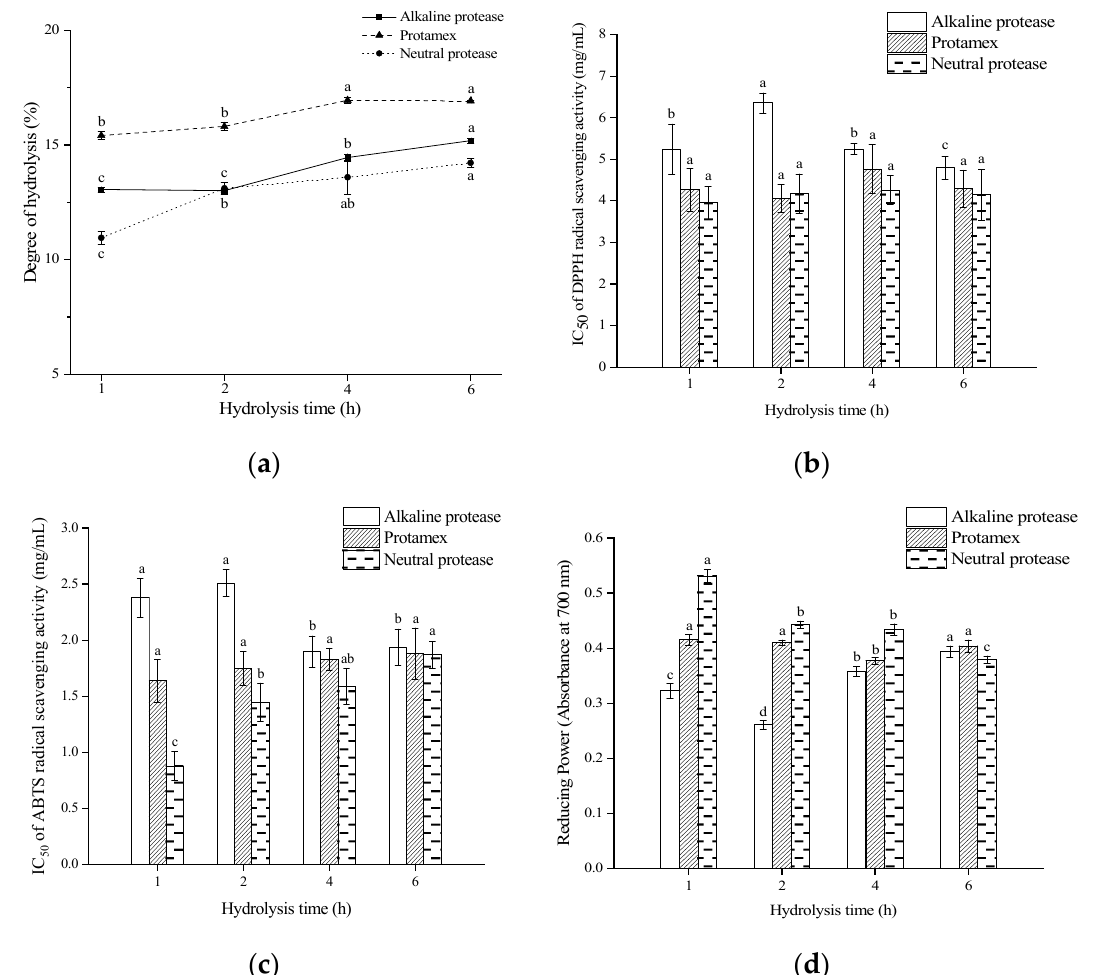
Figure 1. The DH and antioxidant activity of different hydrolysates under different hydrolysis times. ( a ) DH; ( b ) IC 50 of the hydrolysates for DPPH radical scavenging; ( c ) IC 50 of the hydrolysates for ABTS radical scavenging; ( d ) Reducing power of the hydrolysates at 8 mg/mL. Different letters on the top of the same pattern (point or column) indicate the significant difference between the hydrolysates obtained by the same protease at different hydrolysis times ( p < 0.05).